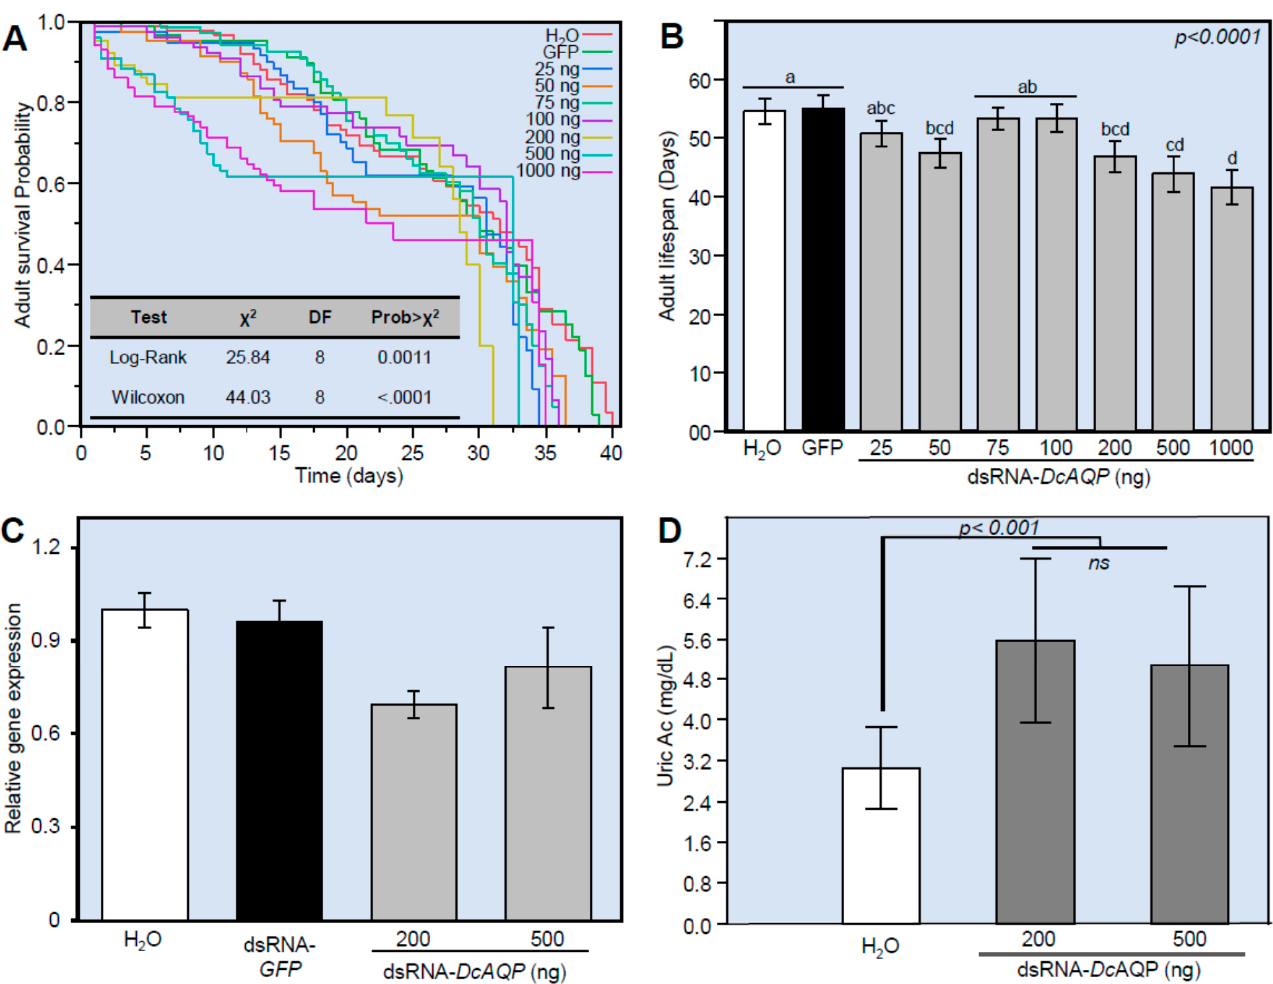
Figure 5. Effect of DcAQP silencing on the survival, DcAQP expression, and uric acid content of emerged adults of D. citri. ( A ) Kaplan–Meier analysis of cumulative survival of D. citri adults emerged from treated nymphs after the treatment with different concentrations of dsRNA- DcAQP (25, 50, 75, 100, 200, 500 and 1000 ng · µ L − 1 ) in comparison with RNase-free water and dsRNA- GFP as controls. p values and χ 2 of log-rank and Wilcoxon tests (presented in the left corner of the graph) were used for statistical comparisons among the survival curves. ( B ) Lifespans associated with cumulative survival of D. citri adults emerged from treated nymphs after the treatment with different concentrations of dsRNA- DcAQP (25, 50, 75, 100, 200, 500 and 1000 ng · µ L − 1 ) in comparison with RNase-free water and dsRNA- GFP as controls. ( C ) Relative gene expression of DcAQP gene after the treatment with 200 or 500 ng · µ L − 1 dsRNA- DcAQP in comparison with RNase-free water and dsRNA- GFP as controls. Gene expressions were normalized using actin as a housekeeping gene, and the changes were analyzed with the 2 − ∆∆ C T method. ( D ) Uric acid content of D. citri adults emerged from nymphs after the treatment with 200 or 500 ng · µ L − 1 dsRNA- DcAQP in comparison with RNase-free water as control. In panels ( B ), ( C ), and ( D ), bars and error bars represent means and SDs, respectively. Different letters indicate statistically significant differences among treatments, while the same letter signifies no significant differences among treatments using Tukey HSD ( p < 0.05). “ns” signify no significant differences among treatments.